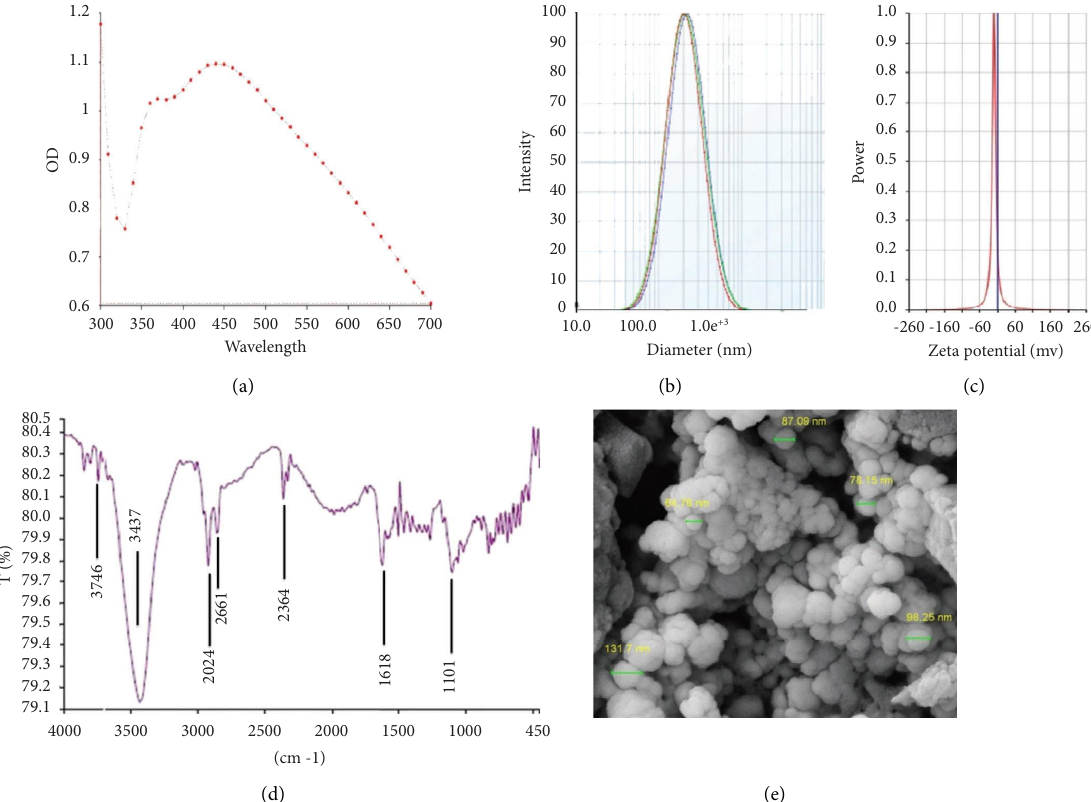
Figure 1: Properties of synthesized AgNPs of quercetin: UV-Vis absorption spectrum (a), particle size distribution (DLS) (b), zeta potential measurement (c), FTIR spectrum, (d) and FESEM image